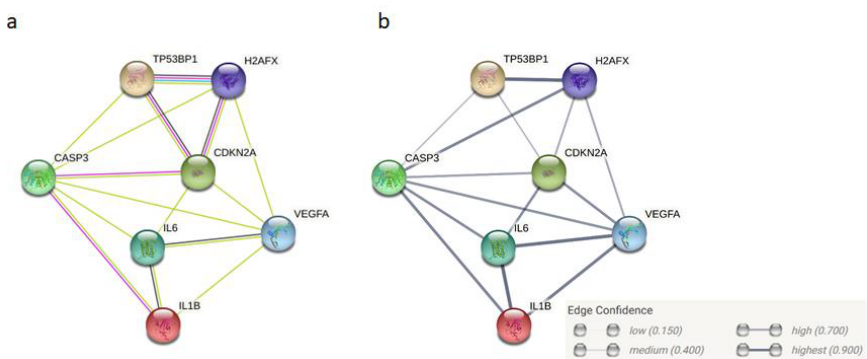
Figure 2. Protein-protein interaction enrichment network generated in STRING 11.0 using proteins identified in at least two studies: p16 (CDKN2A), VEGFA, IL6, IL-1β, CASP3, TP53BP1, and γH2AX: ( a ) The lines represent protein–protein association where pink lines are known experimentally determined interactions, blue from curated databases, green are from text-mining, and black represents co-expression; ( b ) The thickness of the edges display the confidence in interaction: medium (0.400), high (0.700), and highest (0.900) in this network.